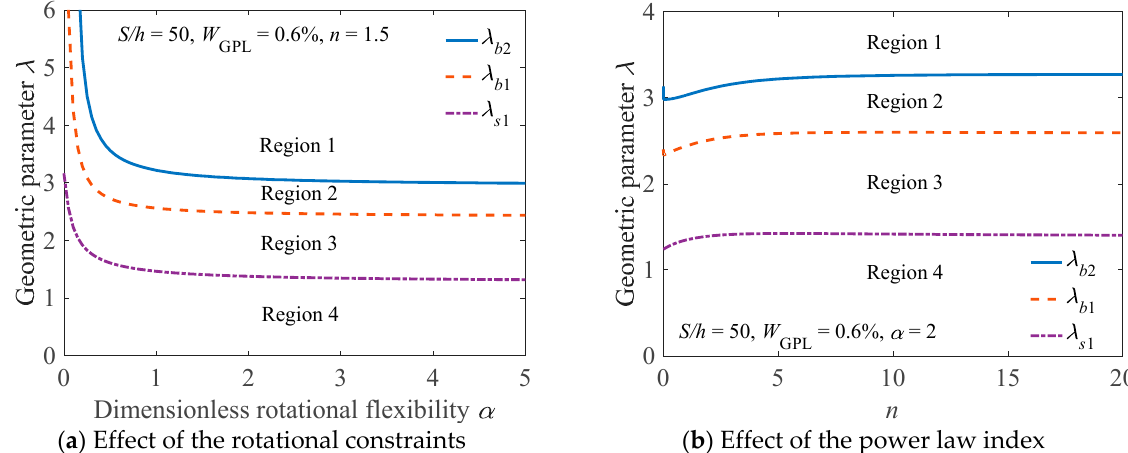
Figure 9. Critical geometric parameters for the buckling mode of an elastically restrained FG-GPLRC arch.